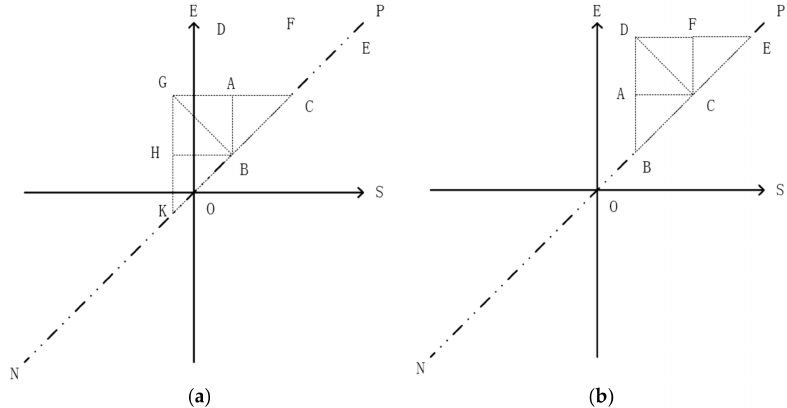
Figure 8. Extensions of the triangle ABC for TIPS. ( a ) Left extension; ( b ) Right